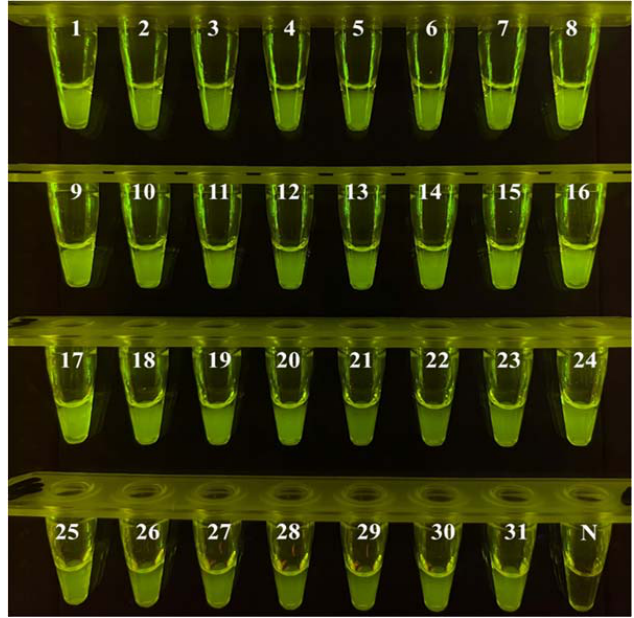
Figure 8. Evaluation of ICB-LAMP-CRISPR/Cas12a in C. jejuni isolates. Thirty-one C. jejuni -positive fecal samples (n = 31) were used in the actual sample evaluation of ICB-LAMP-CRISPR/Cas12a.